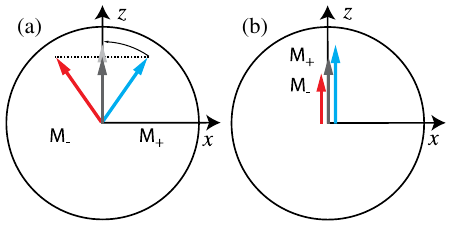
FIG. 1. A Bloch-sphere depiction of the extremes of informa- tion–disturbance tradeoffs. In both panels, the dark arrow rep- resents the Bloch vector of the premeasurement state. The arrows labeled with M (cid:4) correspond to the postmeasurement states conditioned on the random outcome of a weak measurement. (a) The measurement of a state in a complementary or unbiased basis; in this case, the measurement axis is along the x direction. When this occurs, the Bloch vector always elongates, as indi- cated by the light gray arrow (the plus outcome rotated for easy visual comparison). (b) The commuting measurement. In this case, if the measurement result M (cid:2) is obtained, the Bloch vector decreases in